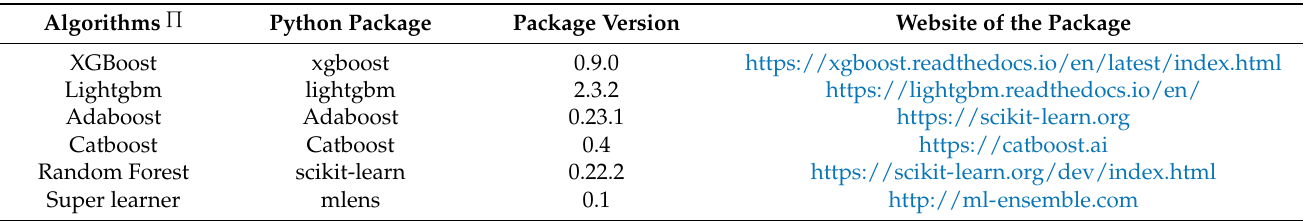
Table 1. Machine learning Algorithms and their